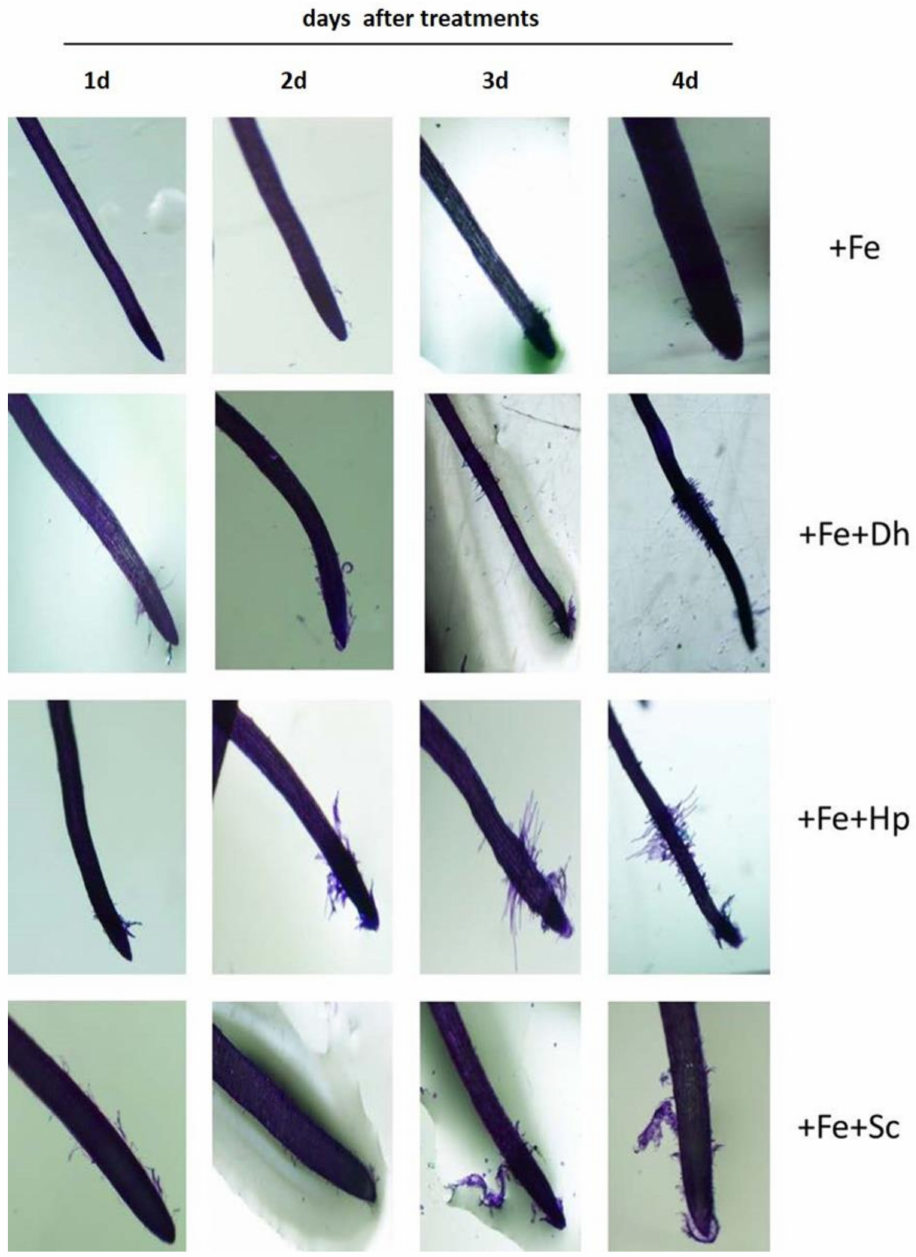
Figure 5. Analysis of development of subapical root hairs in young roots of cucumber plants grown with Fe (+Fe) or with Fe and inoculated with any of the three yeasts studied in this work: Debaryomyces hansenii (+Fe+Dh), Hansenula polymorpha (+Fe+Hp), or Saccharomyces cerevisiae (+Fe+Sc). The inoculation with the yeasts was carried out the same day the Fe-sufficient treatment was applied. Roots were observed 1, 2, 3, and 4 days after treatments (1d, 2d, 3d, and 4d). The images were obtained using a stereoscopic microscope with camera system after having stained the roots with toluidine blue for 10